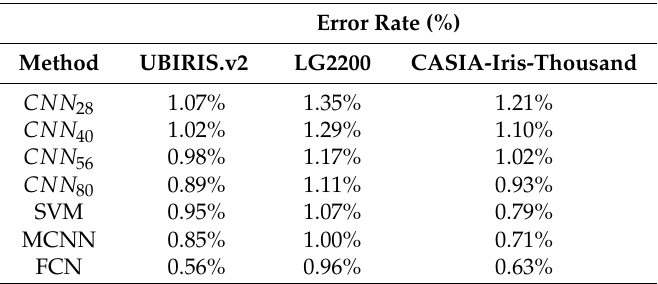
Table 2. Error Rate evaluation of different architectures used in our Method.